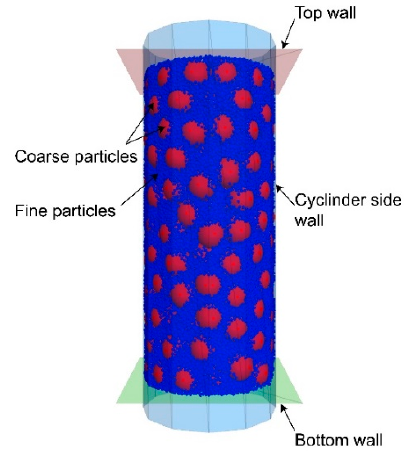
Figure 7. PFC numerical model.